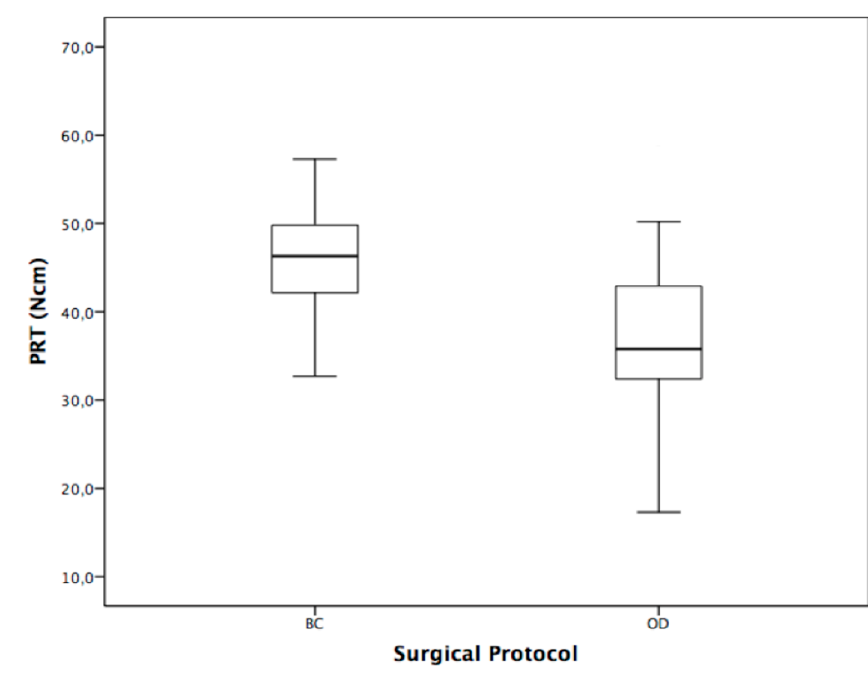
Figure 5. Box plot—removal Figure 5. Box plot—Removal torque. Figure 5. Box plot—Removal torque.